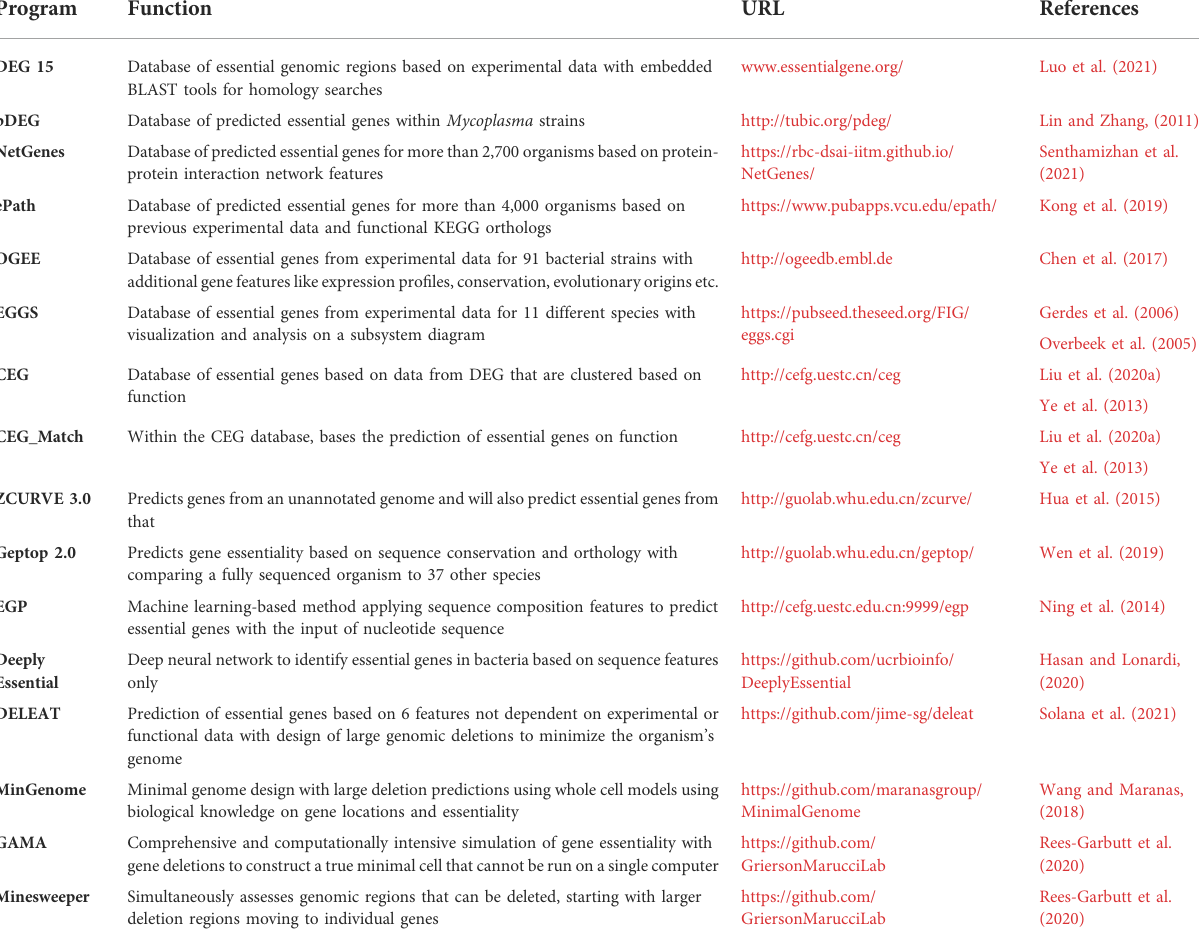
TABLE 2 Essential gene databases and computational programs to predict essential genes and design genomic